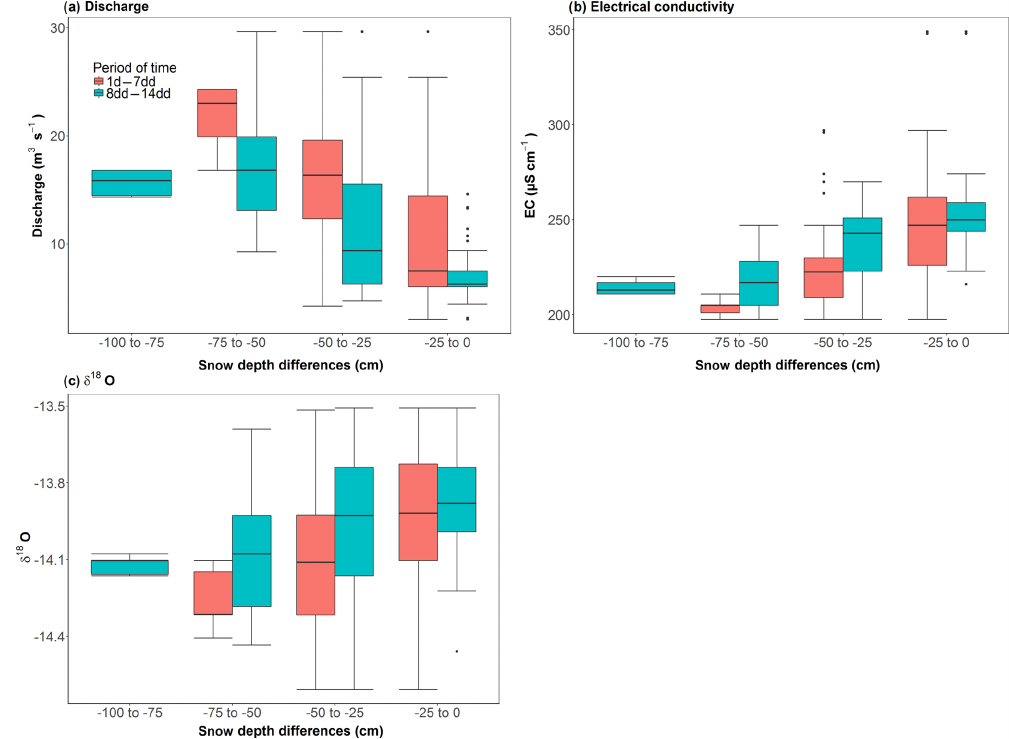
Figure 7. Box plots of snowmelt expressed as snow depth differences at AWS Madritsch on the variability in (a) discharge, (b) EC and (c) δ 18 O at the outlet Stilfserbrücke in 2014 and 2015. dd refers to the days considered for